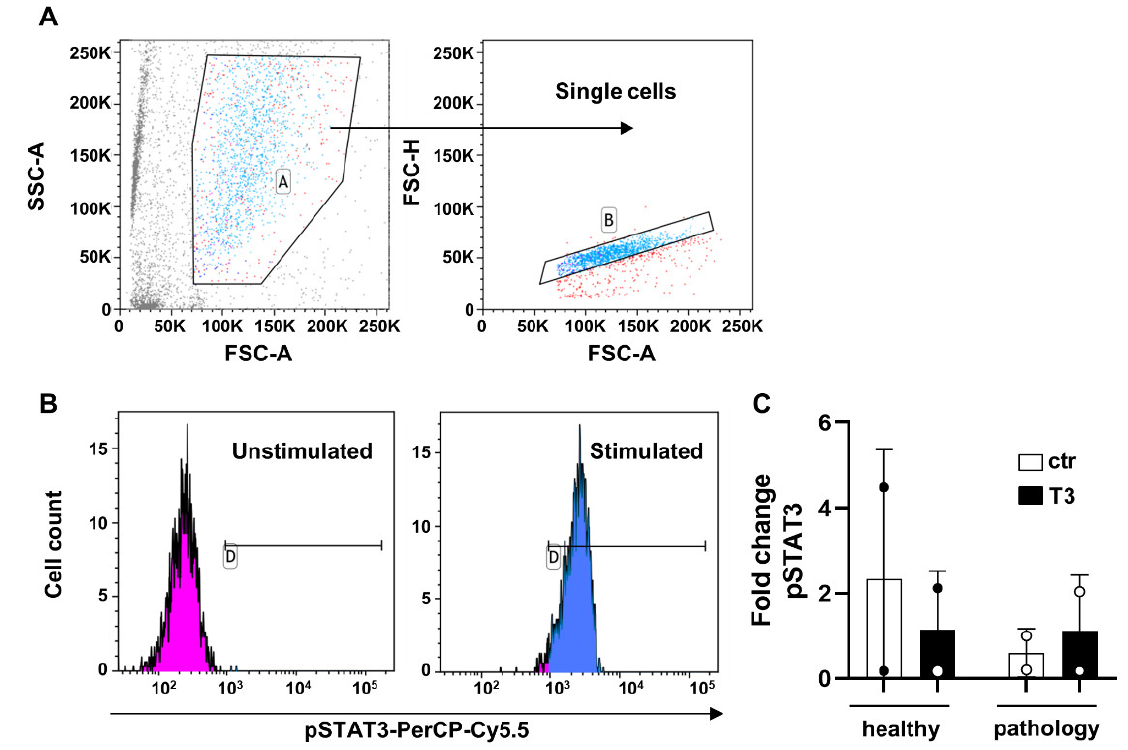
Figure 8. Phosphorylation status analysis of STAT3 by flow cytometry. Healthy and pathological TSPCs were treated (T3) or not (ctr) with T3 for 20 min and then subjected to fixation, permeabilization, antibody staining, and acquisition using a BD FACSVerse flow cytometer. ( A ) TSPCs were identified using linear parameters first (forward side scatter [FSC]-area vs side scatter-area [SSC-A]; gate A), and then double cells were excluded (FSC-A vs FSC-H; gate B). On single cells, ( B ) pSTAT3 expression was investigated. Data are shown as cell count histograms, and results are reported as median fluorescence intensity (MFI) or percent of positive cells (gate D). ( C ) Fold change variations of pSTAT3 expression was expressed as the ratio between T3-stimulated and unstimulated samples (N = 2). Results are shown as mean ± SD.